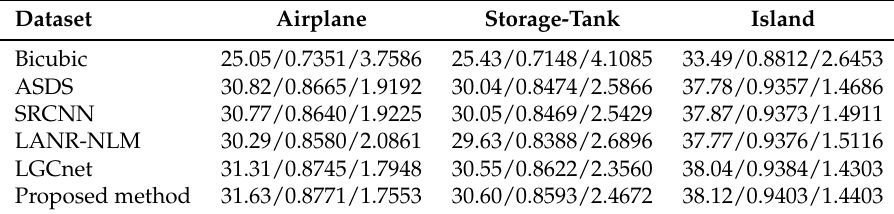
Table 6. PSNR/SSIM/ERGAS Results on Databases (Scale Factor = 3, Noise = 0).